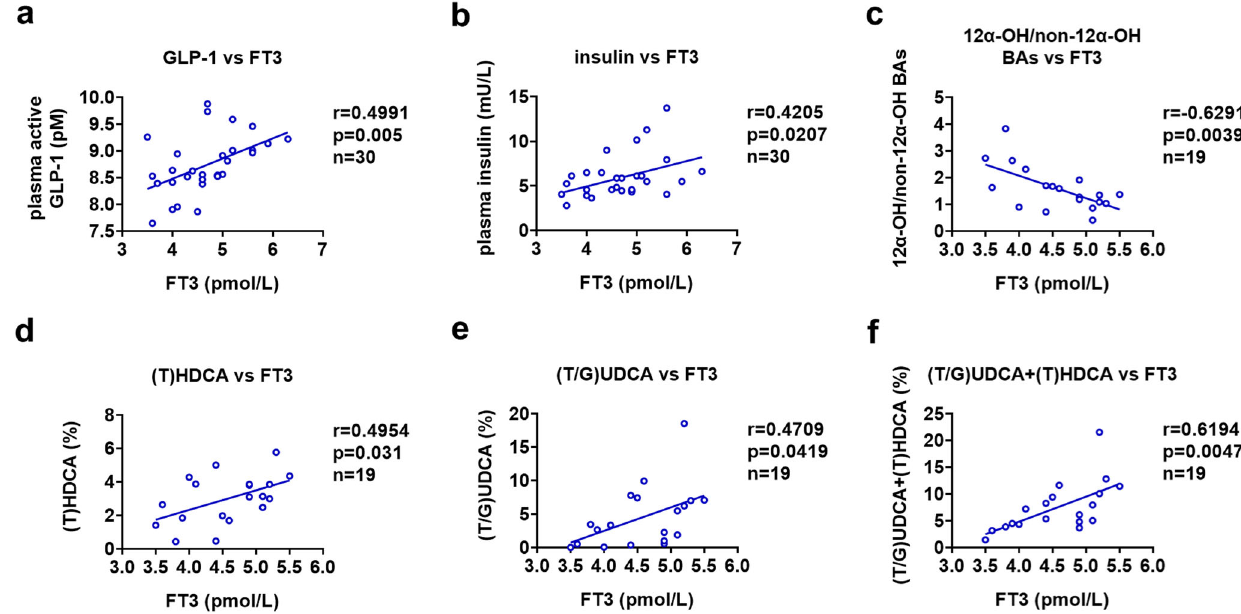
Fig.8|T3levelsareassociatedwithGLP-1andnon-12 α -OHFXR-antagonisticBA levels in humans. a , b Correlation between free T3 levels and plasma active GLP-1 levels ( a ) or plasma insulin levels ( b ) in a cohort of euthyroid human study parti- cipants ( n =30). c – f Association analysis of free T3 levels and fecal BA levels i n another cohort of euthyroid human study participants ( n =19). Correlation of free